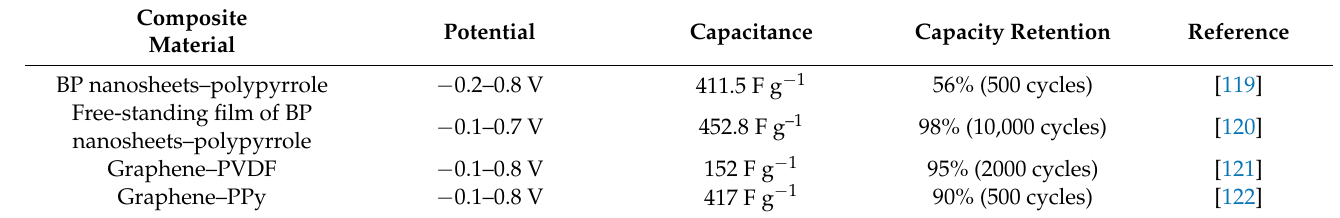
Table 4. Comparative properties of few composites of BP polymers and graphene polymers for su- percapacitors.